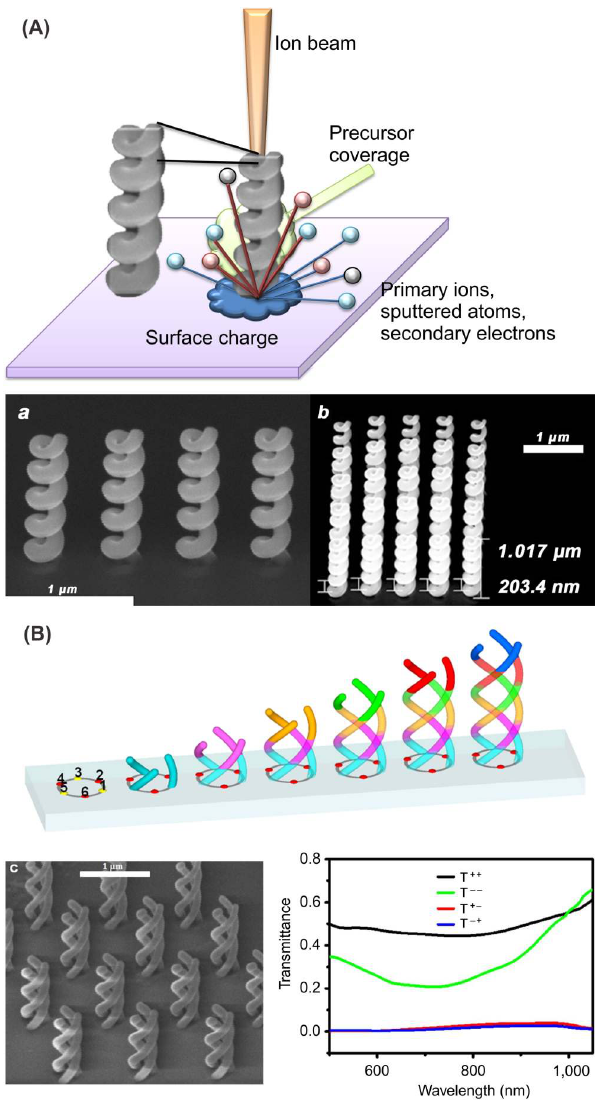
Figure 6: (A) The FIBID fabrication process is depicted schematically in the top panel. The bottom two panels depict scanning electron micrographs of arrays of platinum helices (reprinted with permis- sion from [44]. Copyright 2013 John Wiley and Sons). (B) Tomo- graphic rotatory growth is shown schematically in the top panel, allowing the fabrication of triple-helical nanostructures with FIBID. In the bottom panels, corresponding scanning electron micrographs (left) and transmittance spectra (right) of platinum triple-helical metamaterials are depicted. The scale bar corresponds to one mi- cron (reprinted with permission from [45]. Copyright 2015 Nature Publishing